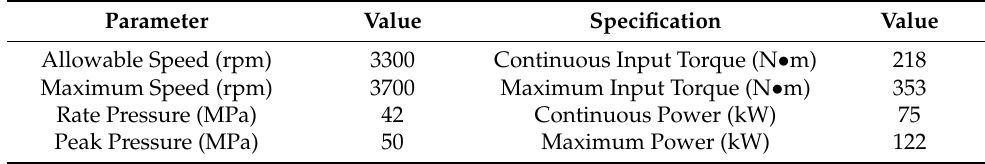
Table 2. Main technical specifications of the variable pump of the HPV-02 model (55 cm 3 /rev). Parameter Value